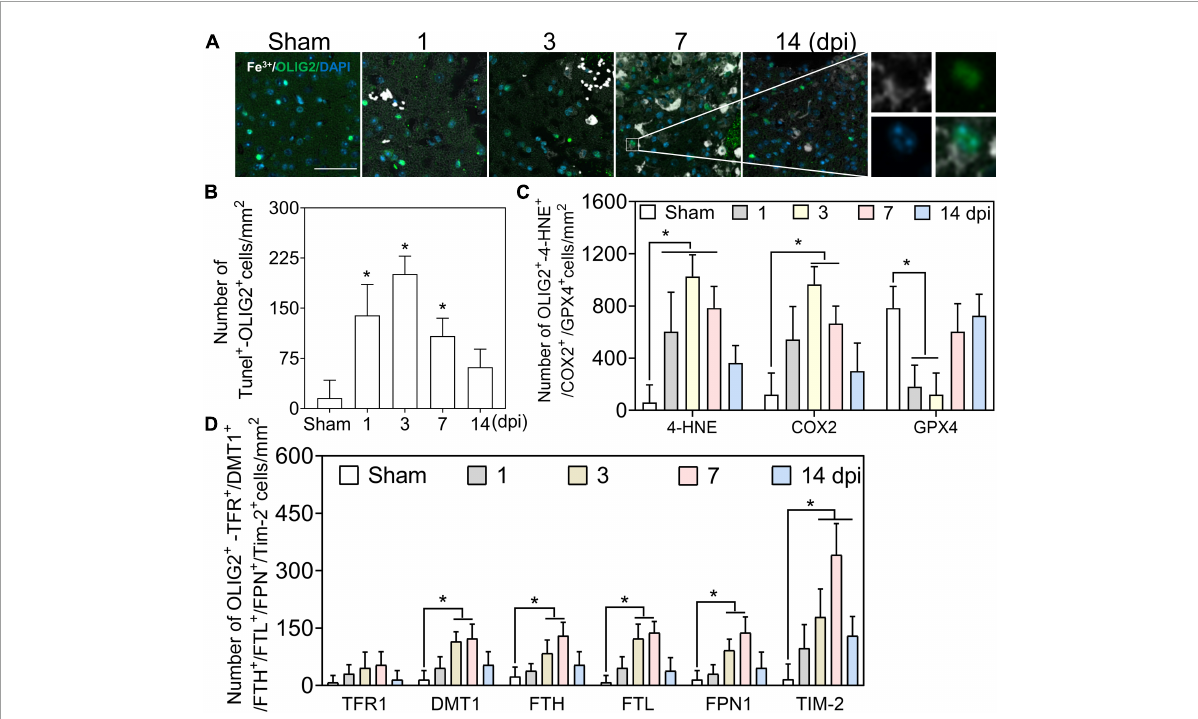
FIGURE4 Iron deposited in oligodendrocytes is beyond oxidative stress. (A) Representative colocation image of Fe 3 + and OLIG2 in ipsilateral-injured cortices of mice at the indicated time ( n = 6, scale bar = 50 µ m). The result shows only several Fe 3 + -positive oligodendrocytes at 7–14 dpi. (B) Quantitative analysis of the number of positive TUNEL-OLIG2 cells in ipsilateral cortices at the indicated time after TBI. Data are presented as mean ± SD, and n = 6. * p < 0.05 versus the Sham group. (C) Quantitative analysis of the number of positive 4-HNE/COX2/GPX4-OLIG2 cells in ipsilateral cortices at the indicated time. Data are presented as mean ± SD, and n = 6. * p < 0.05 versus the Sham group. (D) Quantitative analysis of the number of TFR1/DMT1/FTH/FTL/FPN1/TIM-2-GFAP-positive cells in injured cortices at 3 dpi. Data are presented as mean ± SD, and n = 6. * p < 0.05 versus the Sham group. OLIG2, oligodendrocyte transcription factor; dpi, days post-injury; 4-HNE, 4-hydroxynonenal; COX2, cyclooxygenase-2; GPX4, glutathione peroxidase 4; TFR1, transferrin R1; DMT1, divalent metal transporter 1; FTH, ferritin heavy chain; FTL, ferritin light chain; FPN1,